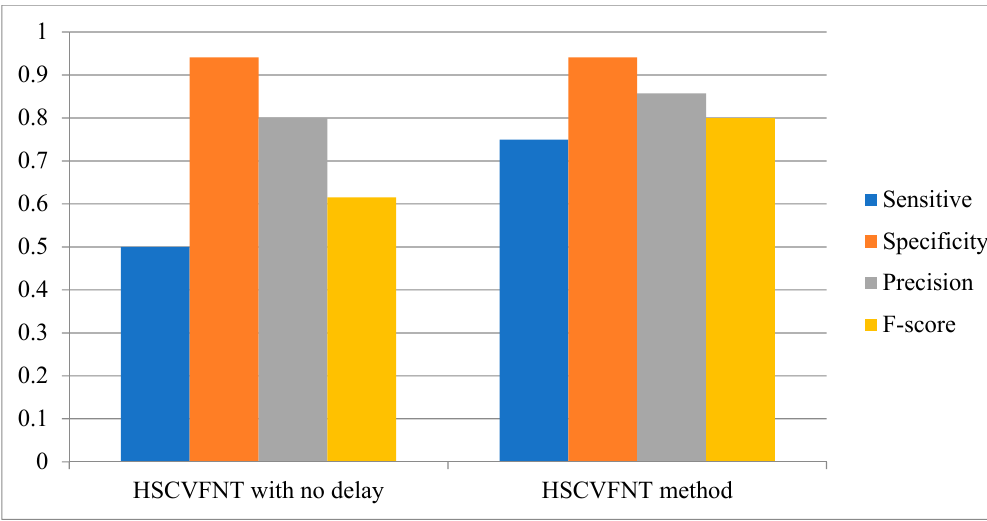
Figure 7. Effect of time-delayed factor for SOS network inference.